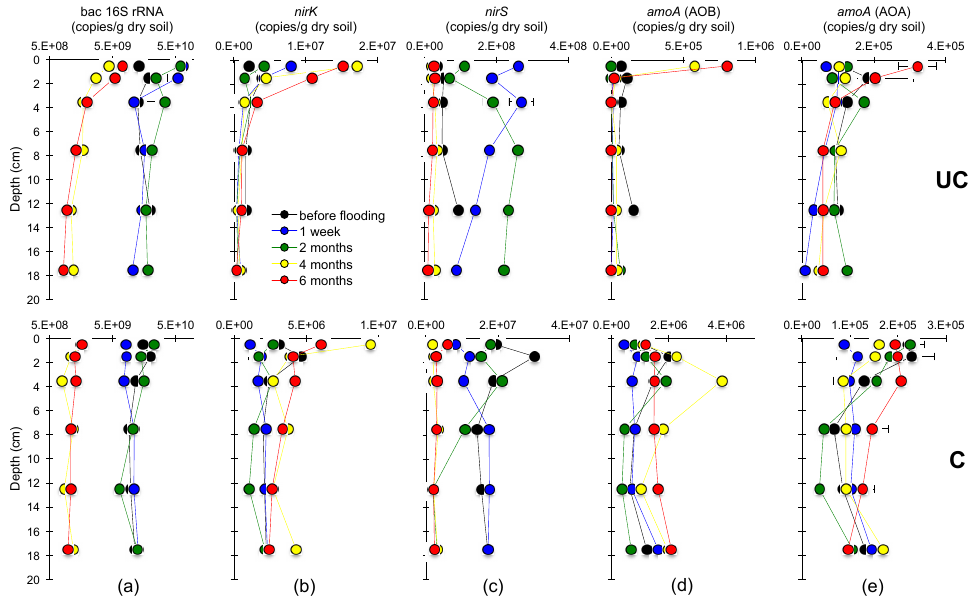
Figure 6. qPCR analysis illustrating abundance depth profiles of: ( a ) the bacterial 16S rRNA gene; ( b ) nirK gene; ( c ) nirS gene; ( d ) amoA gene of ammonia oxidizing bacteria (AOB); and ( e ) amoA gene of ammonia oxidizing archaea (AOA) at the uncultivated (UC) and cultivated (C) station from before flooding and the four sampling time points after flooding with seawater. The copy numbers were normalized directly to gram dry soil and bacterial 16S rRNA gene copy numbers were log transformed. Note different scales on the x-axes. Error indicated as standard error ( n = 2).